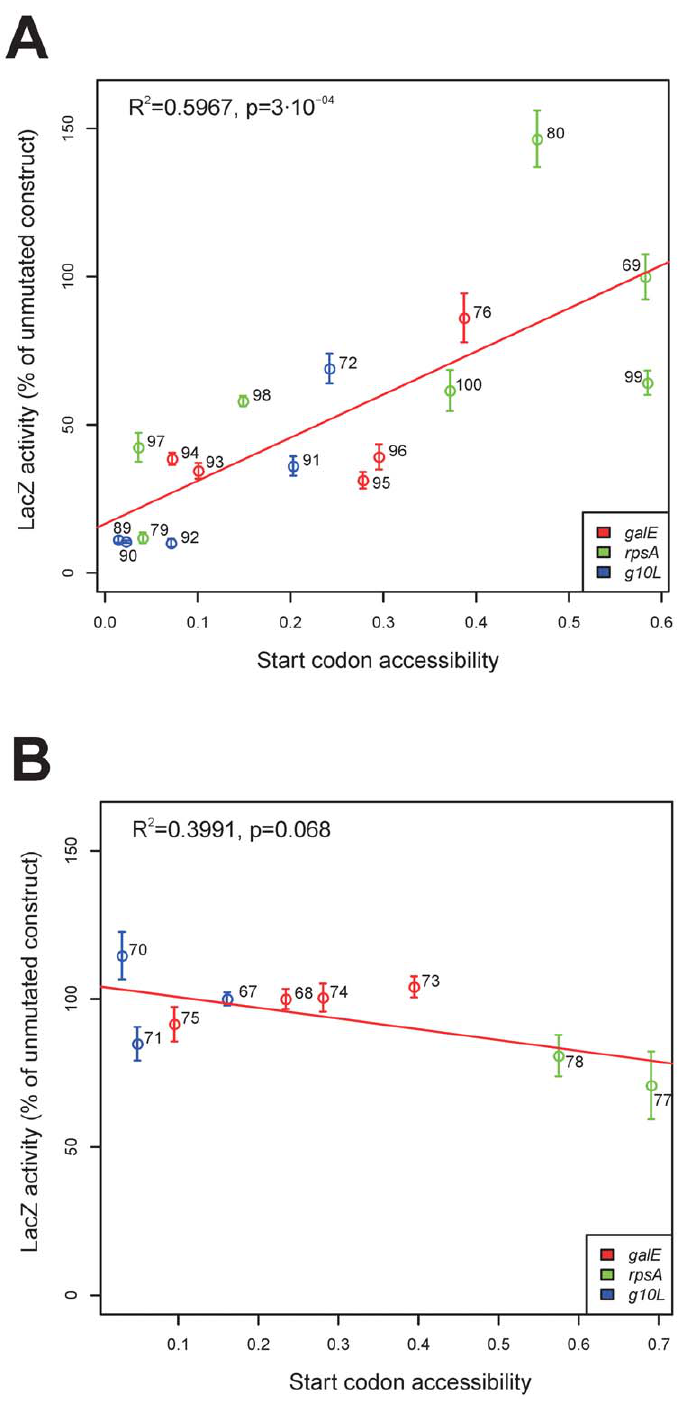
Figure 4. Experimental testing of the unfoldedness hypothesis for SD–independent translation. (A) Correlation between LacZ activity and accessibility of the start codon in constructs without a SD sequence. (B) Lack of a significant correlation between LacZ activity and accessibility of the start codon in constructs with a SD sequence. The 5 9 UTRs on which the individual constructs were based are indicated by color-coding. The LacZ activity was normalized to the activity of the unmutated construct ( g10L : pLS67; galE : pLS68; rpsA : pLS69; cp. Figure 3). The start codon accessibility was calculated as the probability that every position of the start codon is unbound and was determined by RNAplfold [34] using a window size of 50 nt and an unbound region size of 3 nt. (Figure 4A). This correlation was statistically highly significant containing the SD motif (Figure 4B). Also, there was no correlation with a p-value of 3.0 ? 10 2 04 and a coefficient of correlation (R 2 ) of between the accessibility of the SD and the LacZ activity (Figure 0.6. In contrast, no such correlation was seen in the constructs S6). Most importantly, mutational elimination of the SD sequence